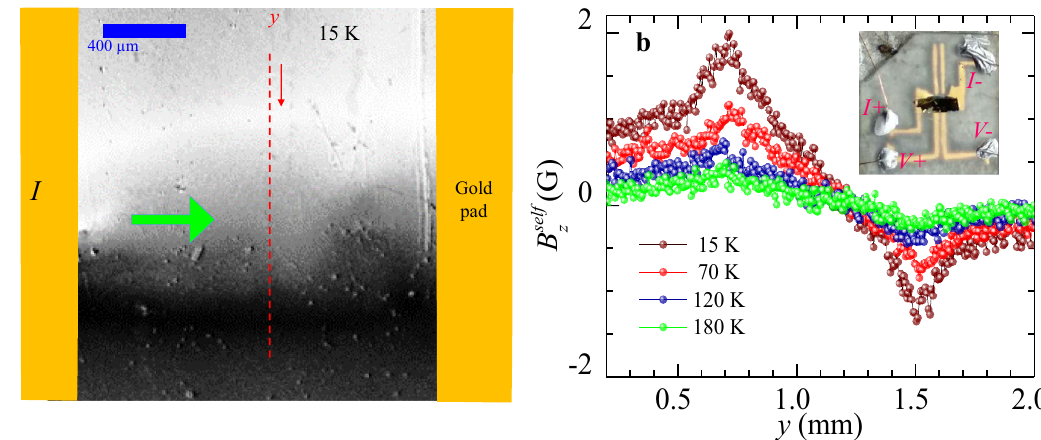
self , y ) measured at 15 K. The z ( x